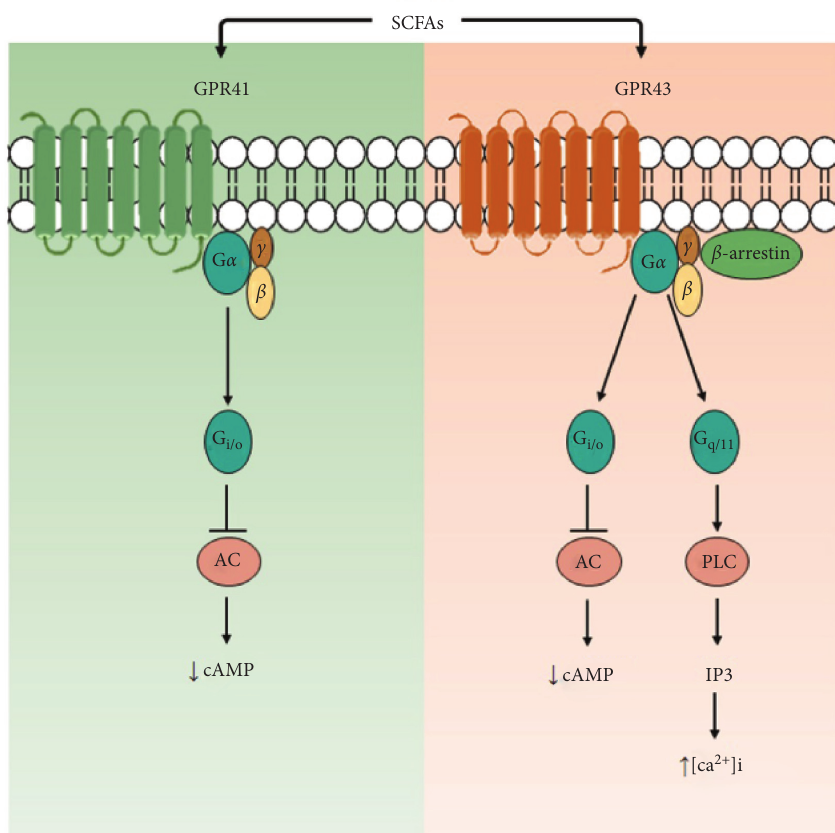
Figure 3: Signaling pathways of GPR41 and GPR43 activated by SCFAs. The signaling pathway downstream of each receptor is illustrated. AC, adenylate cyclase; [Ca 2+ ] i , intracellular Ca 2+ concentration; GPR, G protein-coupled receptor; IP3, inositol trisphosphate; PLC, phospholipase C; SCFAs, short-chain fatty